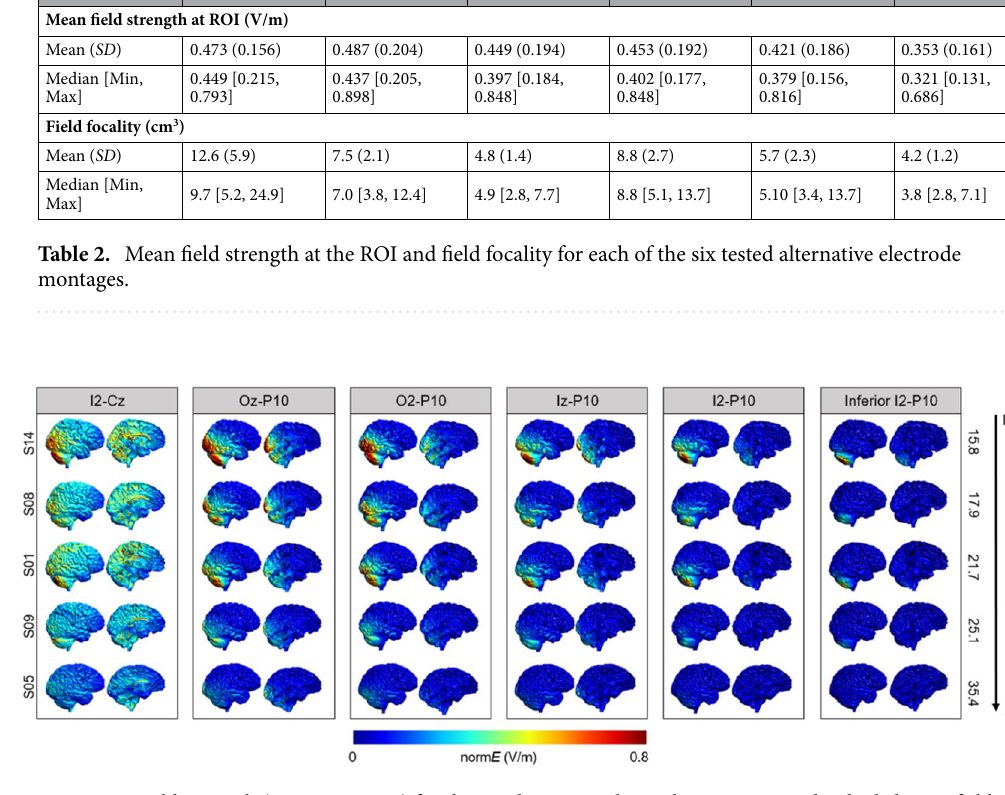
Figure 5. Field strength (normE in V/m) for the six alternative electrode montages. Individual electric fields are depicted for five individuals representative of the range of scalp–cortex distance. An illustration of individual electric fields of all individuals included in the study can be found in the “Supplementary Materials” (Fig. S3).